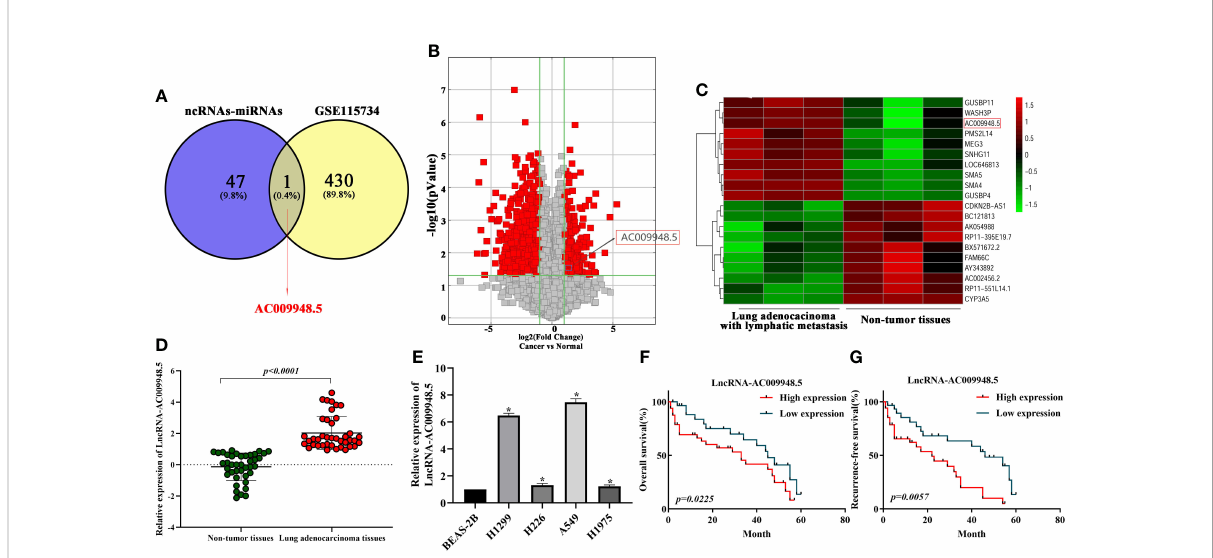
FIGURE 1 Expression of LncRNA-AC009948.5 is up-regulated in lung adenocarcinoma cells and tissues, and patients with a high level of LncRNA- AC009948.5 demonstrate poor prognosis. (A) Schematic fl owchart showed the overlapping of LncRNA could combine with miR-186-5p and the upregulated and LncRNAs collection in LncRNA microarray data (GSE115734) ( fi ltered by fold change ≥ 2 and p-value ≤ 0.05). (B) Volcano plots show that thousands of LncRNAs are signi fi cantly different by using lncRNA expression thresholds of more than twofold change with P< 0.05 in GSE115734. (C) Clustered heatmap of signi fi cant differentially expressed LncRNAs in GSE115734. Each sample contained a mixture of three repeats, red represents high expression, and green represents low expression. (D) Expression of LncRNA-AC009948.5 in 80 lung adenocarcinoma tissues and paired non-tumor ones analyzed by qRT-PCR. GAPDH was used as an internal control. The results were expressed as Log2. (E) Expression of LncRNA-AC009948.5 in human normal lung epithelial cells (BEAS-2B) and human lung adenocarcinoma cell lines (H1299, H226, A549, and H1975). GAPDH was used as an internal control. Data represent the mean ± S. D, *P<0.05 versus on BEAS-2B cells. The results were repeated three times independently. (F) Kaplan-Meier analysis for overall survival based on differential expression levels of LncRNA-AC009948.5 in patients with lung adenocarcinoma. (G) Kaplan-Meier analysis for recurrence-free survival based on different expression levels of LncRNA-AC009948.5 in patients with lung